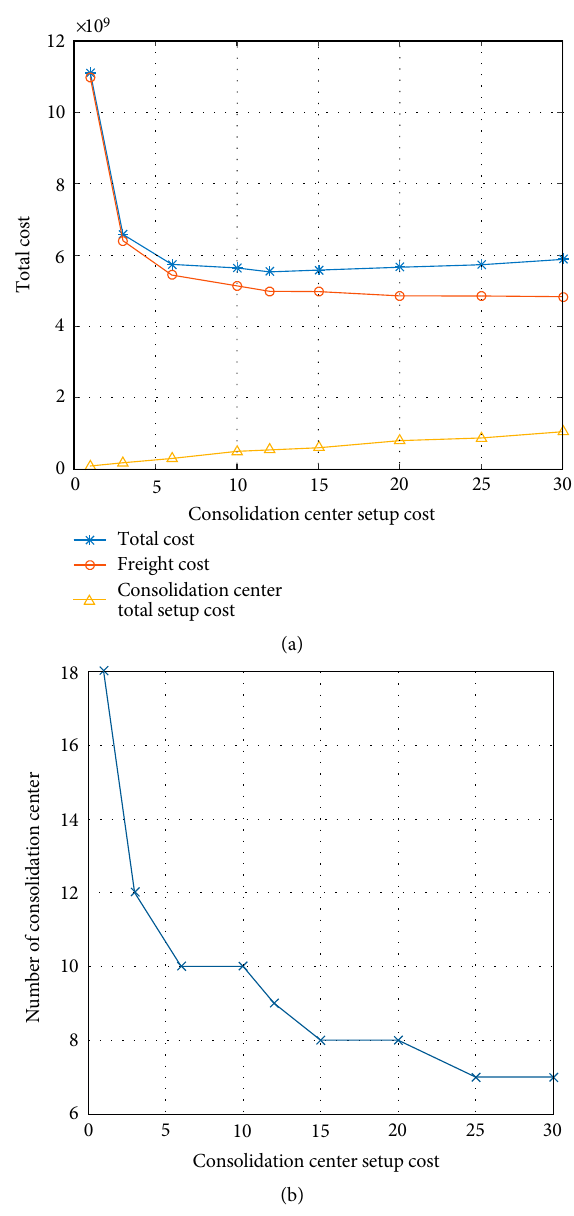
Figure 11: Impacts of the setup cost per consolidation center on the (a) total cost ( TC ) of the CRENC and (b) optimal number of consolidation